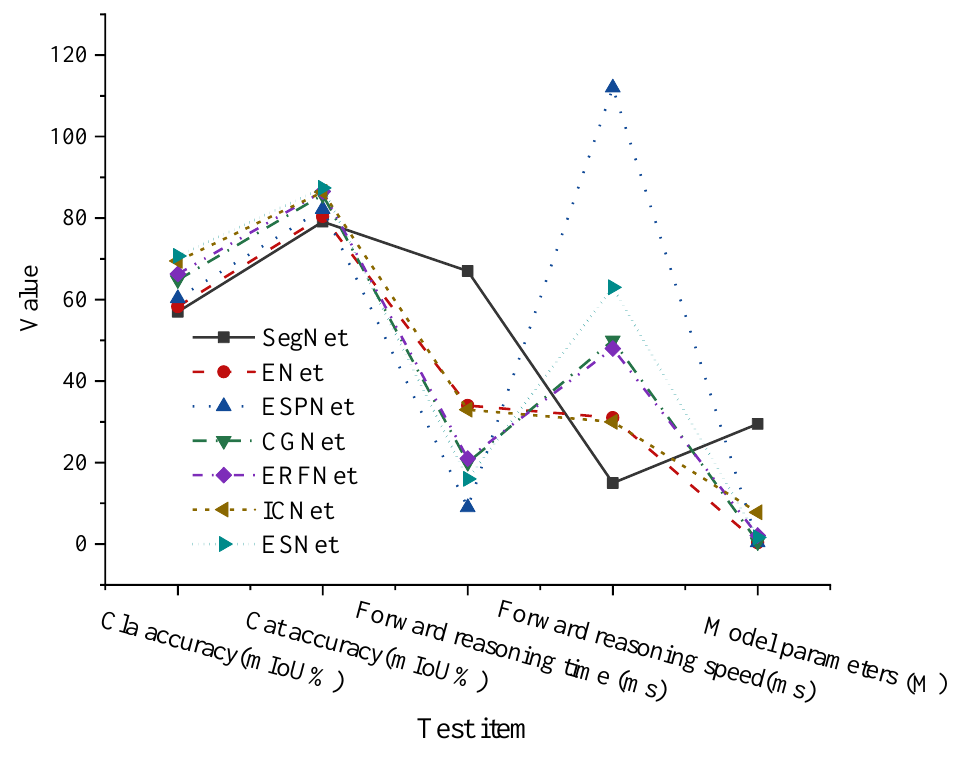
Figure 14. Comparison results of various segmentation methods.